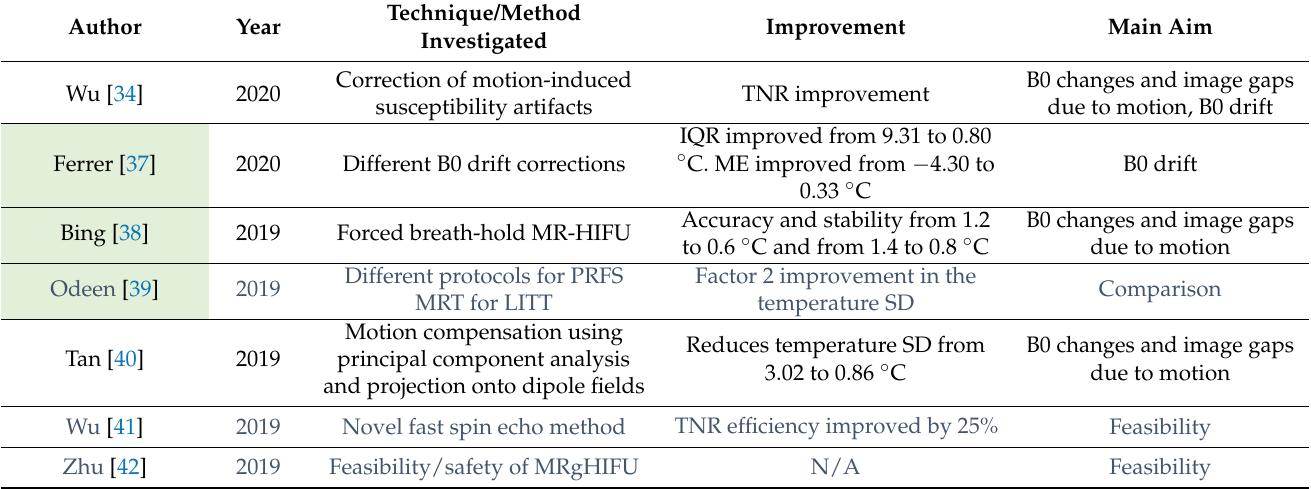
Table 5. Pre-clinical studies by the year of publication; including technique/method investigated, improvement found (where applicable) and main aim of the study. Feasibility and comparison studies are presented in grey. Studies satisfying our performance criterion are highlighted in green.